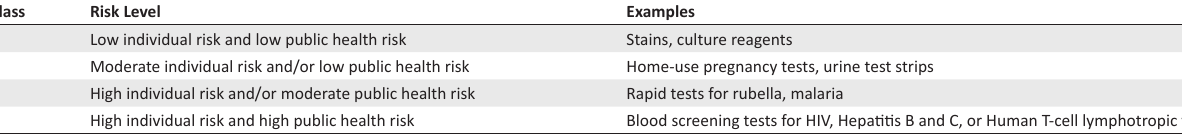
TABLE 1: Classification of medical devices with examples of diagnostic products.